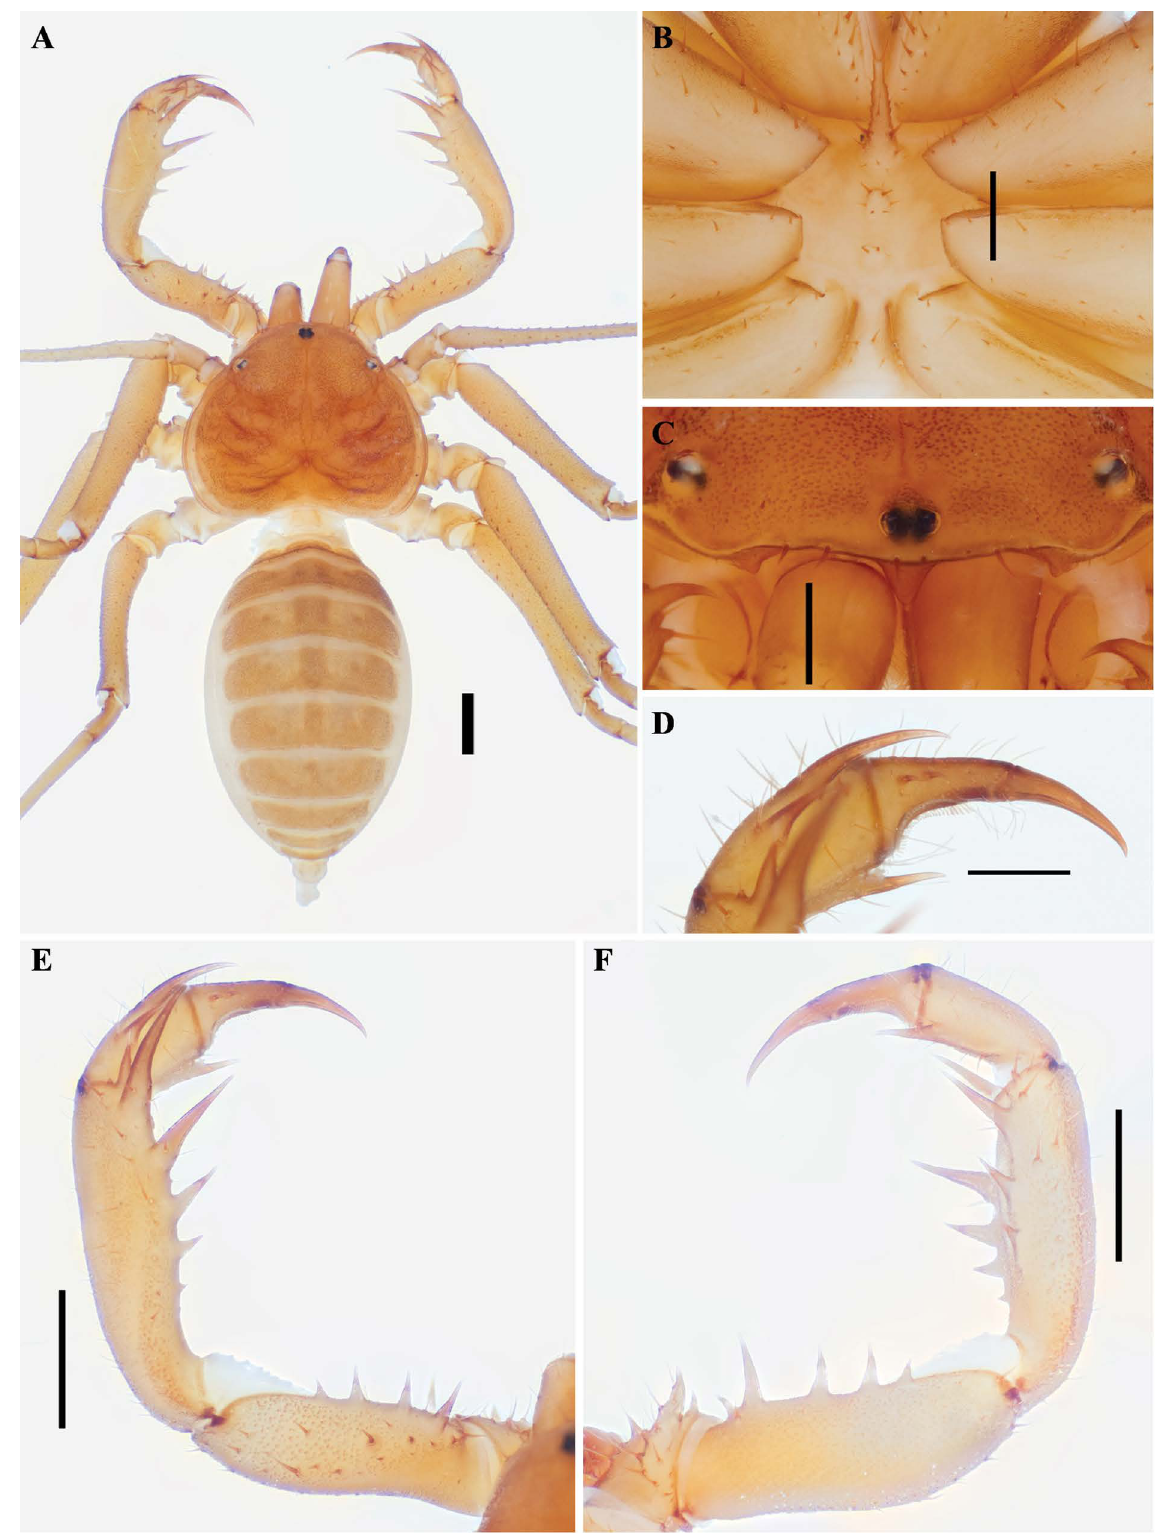
Fig. 112. Sarax indochinensis sp. nov. (ZMUC 21613), general morphology, ♀. A . Habitus, dorsal view. B . Sternum, ventral view. C . Frontal process. D . Pedipalp tarsus, frontal view. E . Pedipalp, dorsal view. F . Pedipalp, ventral view. Scale bars: A, E–F = 1 mm; B–D = 0.5